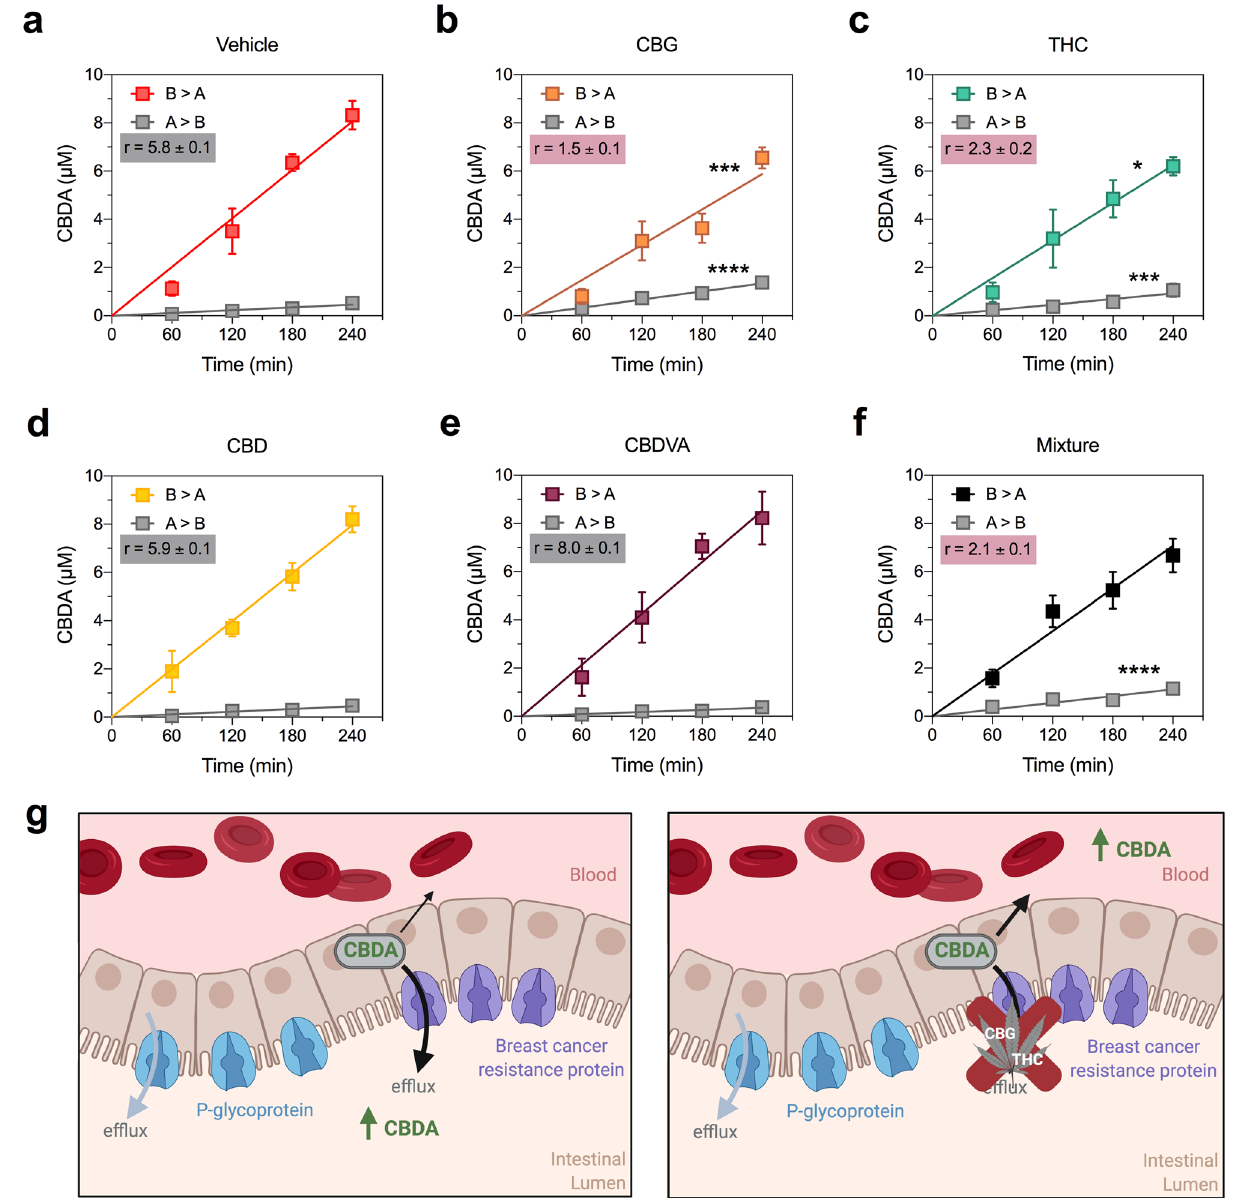
Figure 3. CBG and Δ 9 -THC inhibit BCRP-mediated transport of CBDA. Concentration–time curves for CBDA in the presence of ( a ) vehicle, ( b ) CBG, ( c ) Δ 9 -THC and ( d ) CBD, ( e ) CBDVA and ( f ) a mixture of all four cannabinoids in the basolateral to apical (B > A) and apical to basolateral (A > B) directions in cells expressing BCRP. Cannabinoids were tested at 10 µM. CBG and Δ 9 -THC significantly inhibit (red shading) transport of CBDA. Data are expressed as means ± SEM, with n = 4 per time point. Curves represent fits to a linear regression and transport efflux ratios (r) are listed (* p < 0.05, *** p < 0.0005, **** p < 0.0001 compared to vehicle; Extra sum- of-squares F test). ( g ) Schematic of CBDA efflux by BCRP located in the intestinal lumen when administered alone (left panel) or as a full-spectrum cannabis extract where its efflux is inhibited by CBG and Δ 9 -THC (right panel). Schematic created using